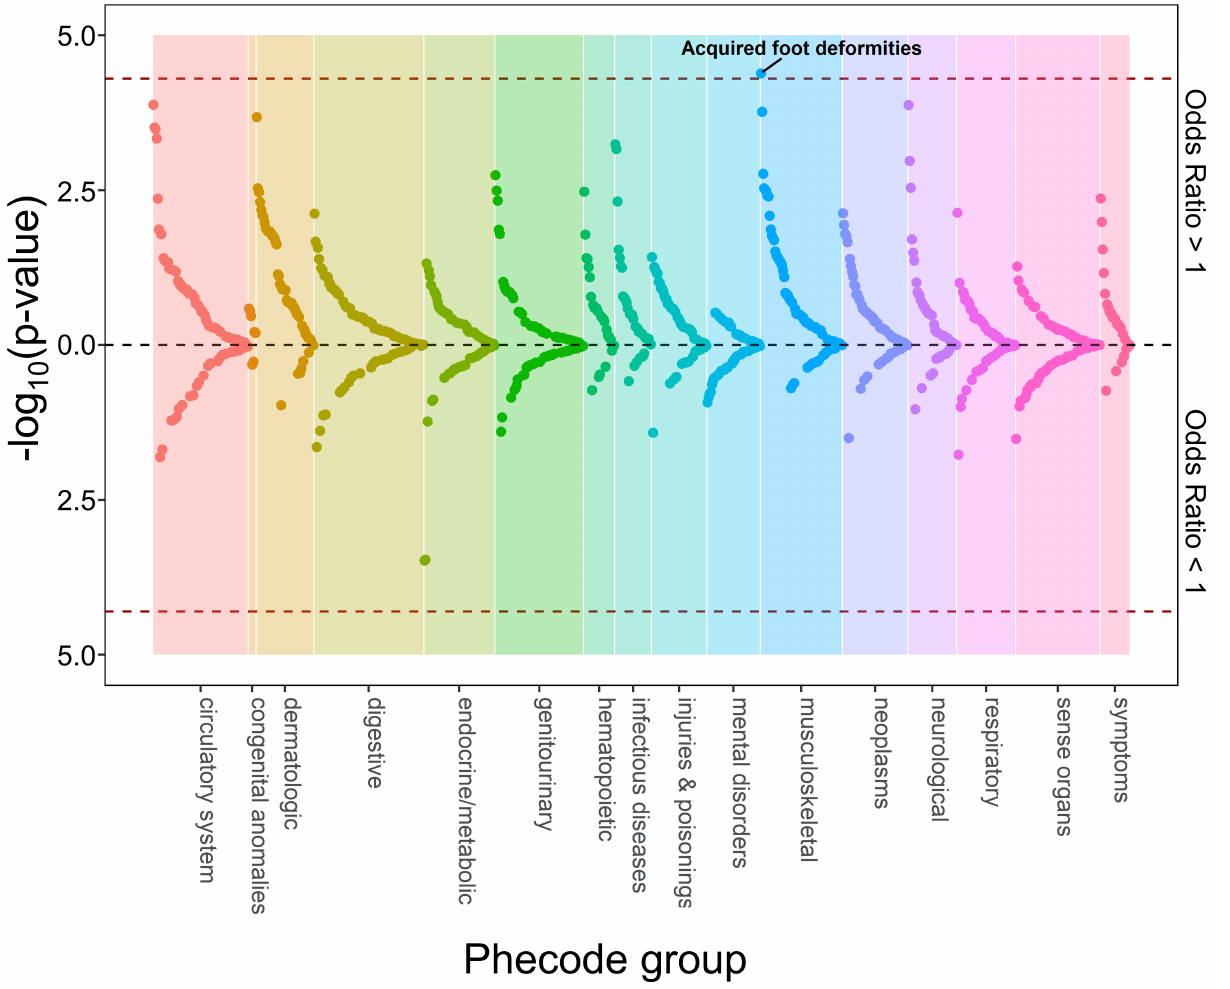
PLOS Genetics | https://doi.org/10.1371/journal.pgen.1010193 June 2,